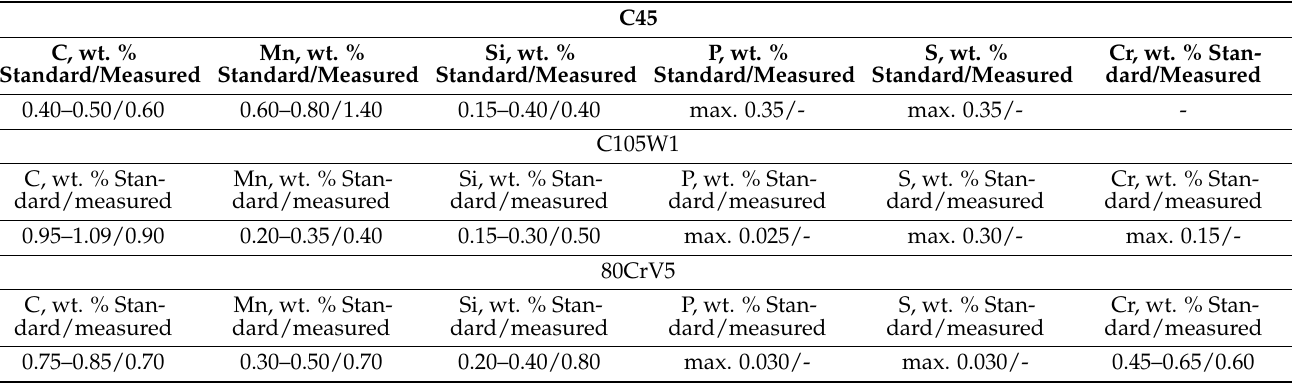
Table 1. Chemical composition of the used